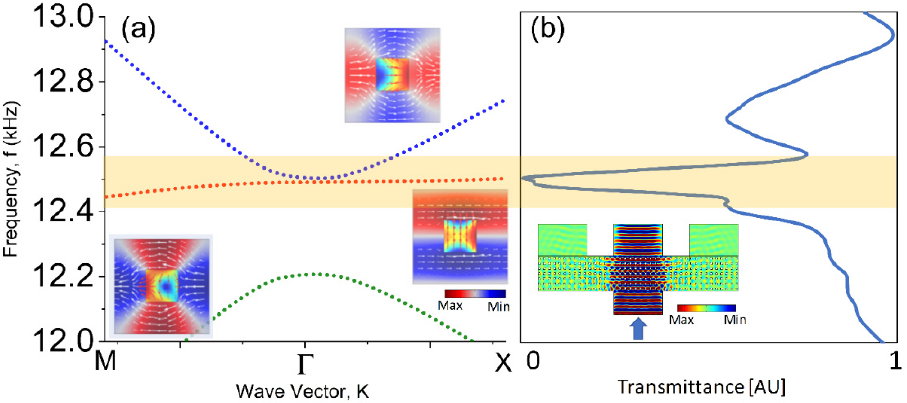
Figure 2. ( a ) The dispersion relation near DRA with the acoustic pressure mode distribution and solid displacement mode distribution of three of the bands near Γ point. The red band is termed as deaf band, ( b ) the deafness of the red deaf band is proved by the numerical calculation of the transmissibilty study through a 40 × 7 cell of PVC/air matrix, showing almost zero transmission near the “deaf band”.